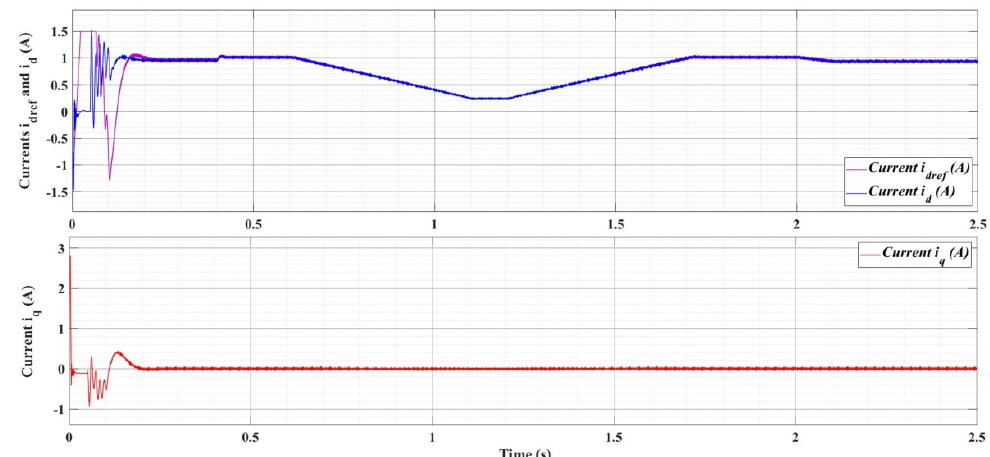
Figure 29. The time evolution of the i d and i q currents (signal evolution of the type 1 PV array).